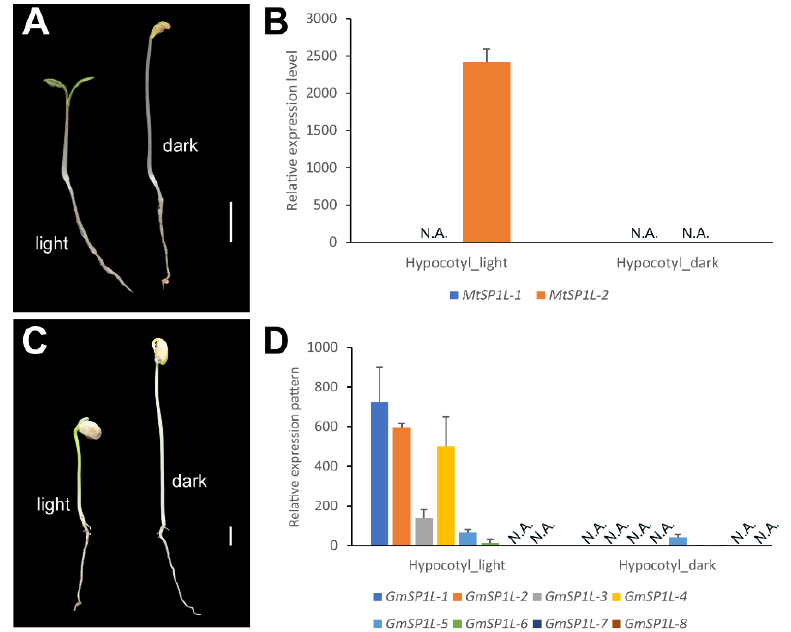
Figure 7. The expression patterns of SP1L genes in response to light stress in M. truncatula (R108) and G. max (Williams 82). The seedlings of ( A ) M. truncatula and ( C ) G. max under white-light and dark growth conditions. The qRT-PCR shows the relative expression levels of the SP1L genes in ( B ) M. truncatula and ( D ) G. max hypocotyls. The bar in ( A , C ) equals 1 cm. ‘N.A.’ indicates undetectable expression.